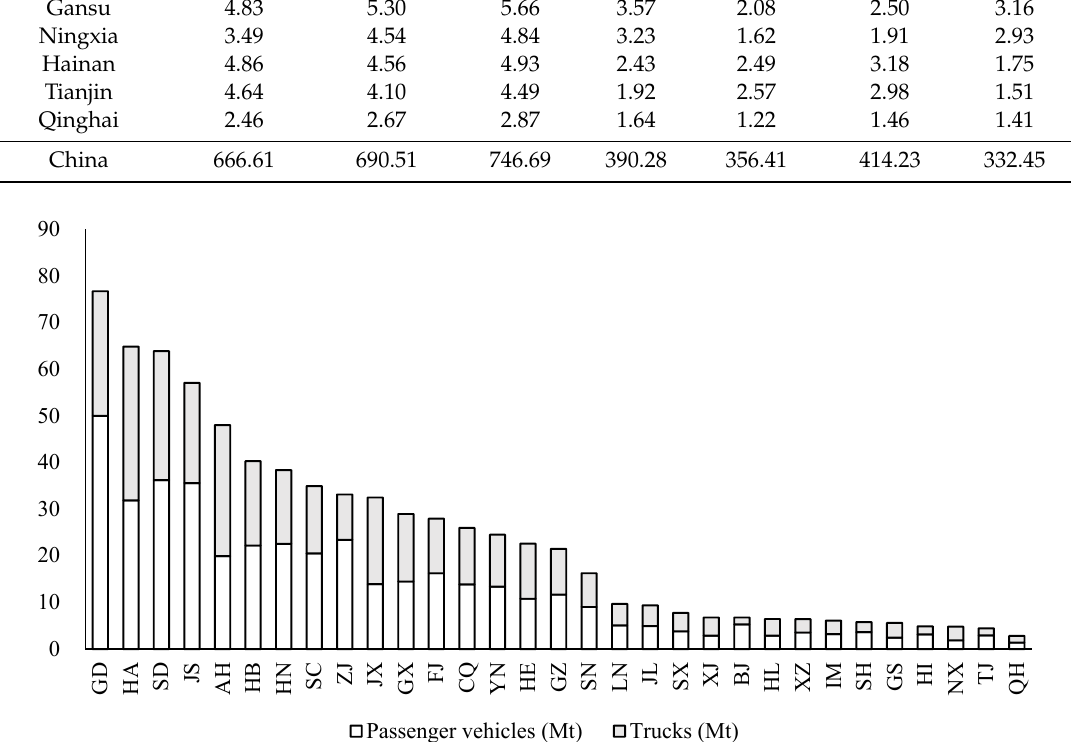
Figure 6. Provincial projections of fuel consumption in 2035.